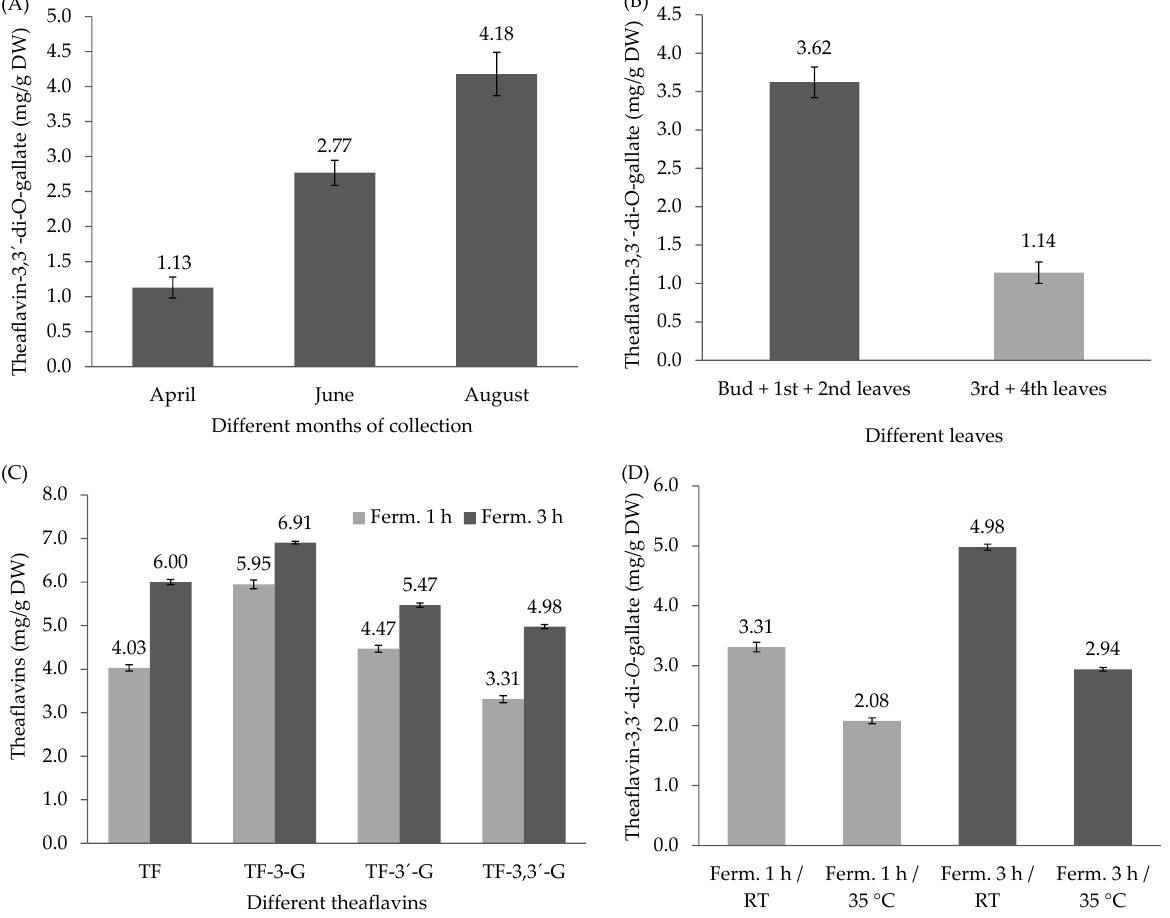
Figure 5. ( A ) Different theaflavin- 3,3′ -di- O -gallate content in the same zone but from different months; ( B ) different theaflavin- 3,3′ -di- O -gallate content in the same zone but from different parts of the tea plant; ( C ) variability of different theaflavins contents according to different fermentation times (1 h vs. 3 h); ( D ) the effect of room temperature (RT) vs. 35 °C on theaflavin- 3,3′ -di- O -gallate content from the same tea plantation zone and at different fermentation times (1 h vs. 3 h).